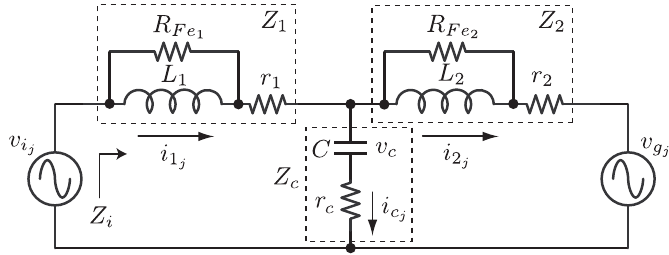
Figure 2. Model of the LCL filter in the αβ reference frame ( j = { α , β } ).